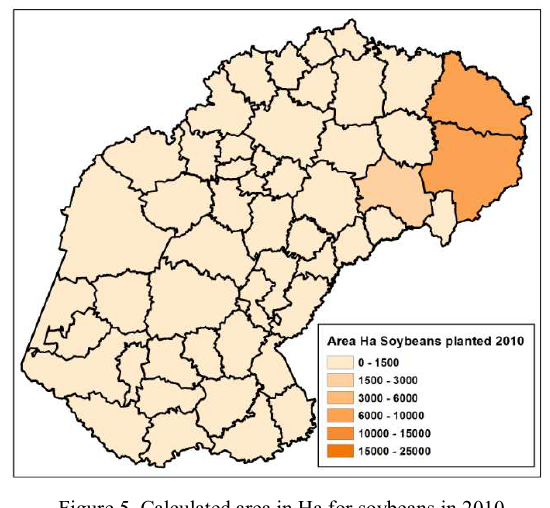
Figure 5. Calculated area in Ha for soybeans in 2010